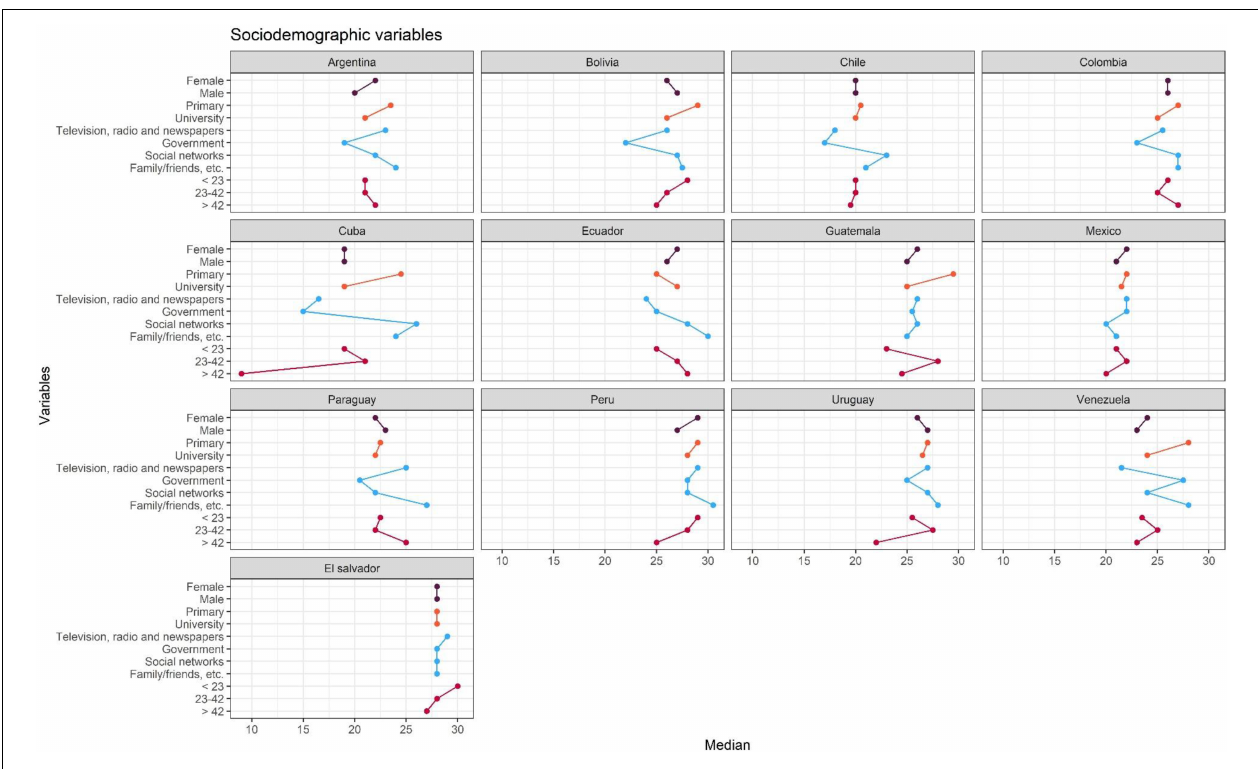
FIGURE 3 | Median for each of the sociodemographic variables by